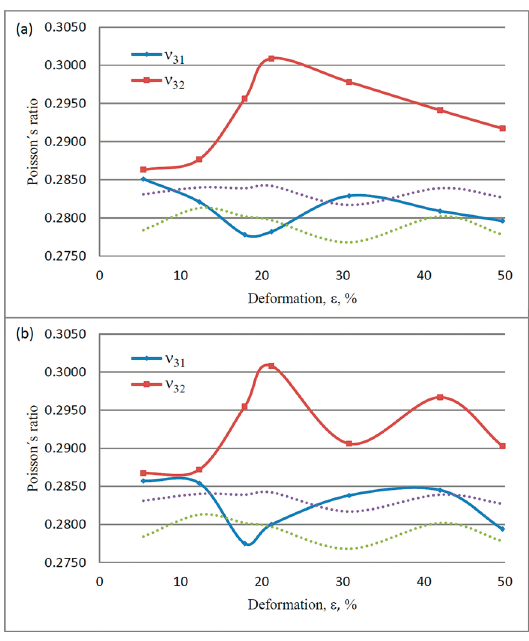
and ν in 31 32 and ν before rolling). 31 32